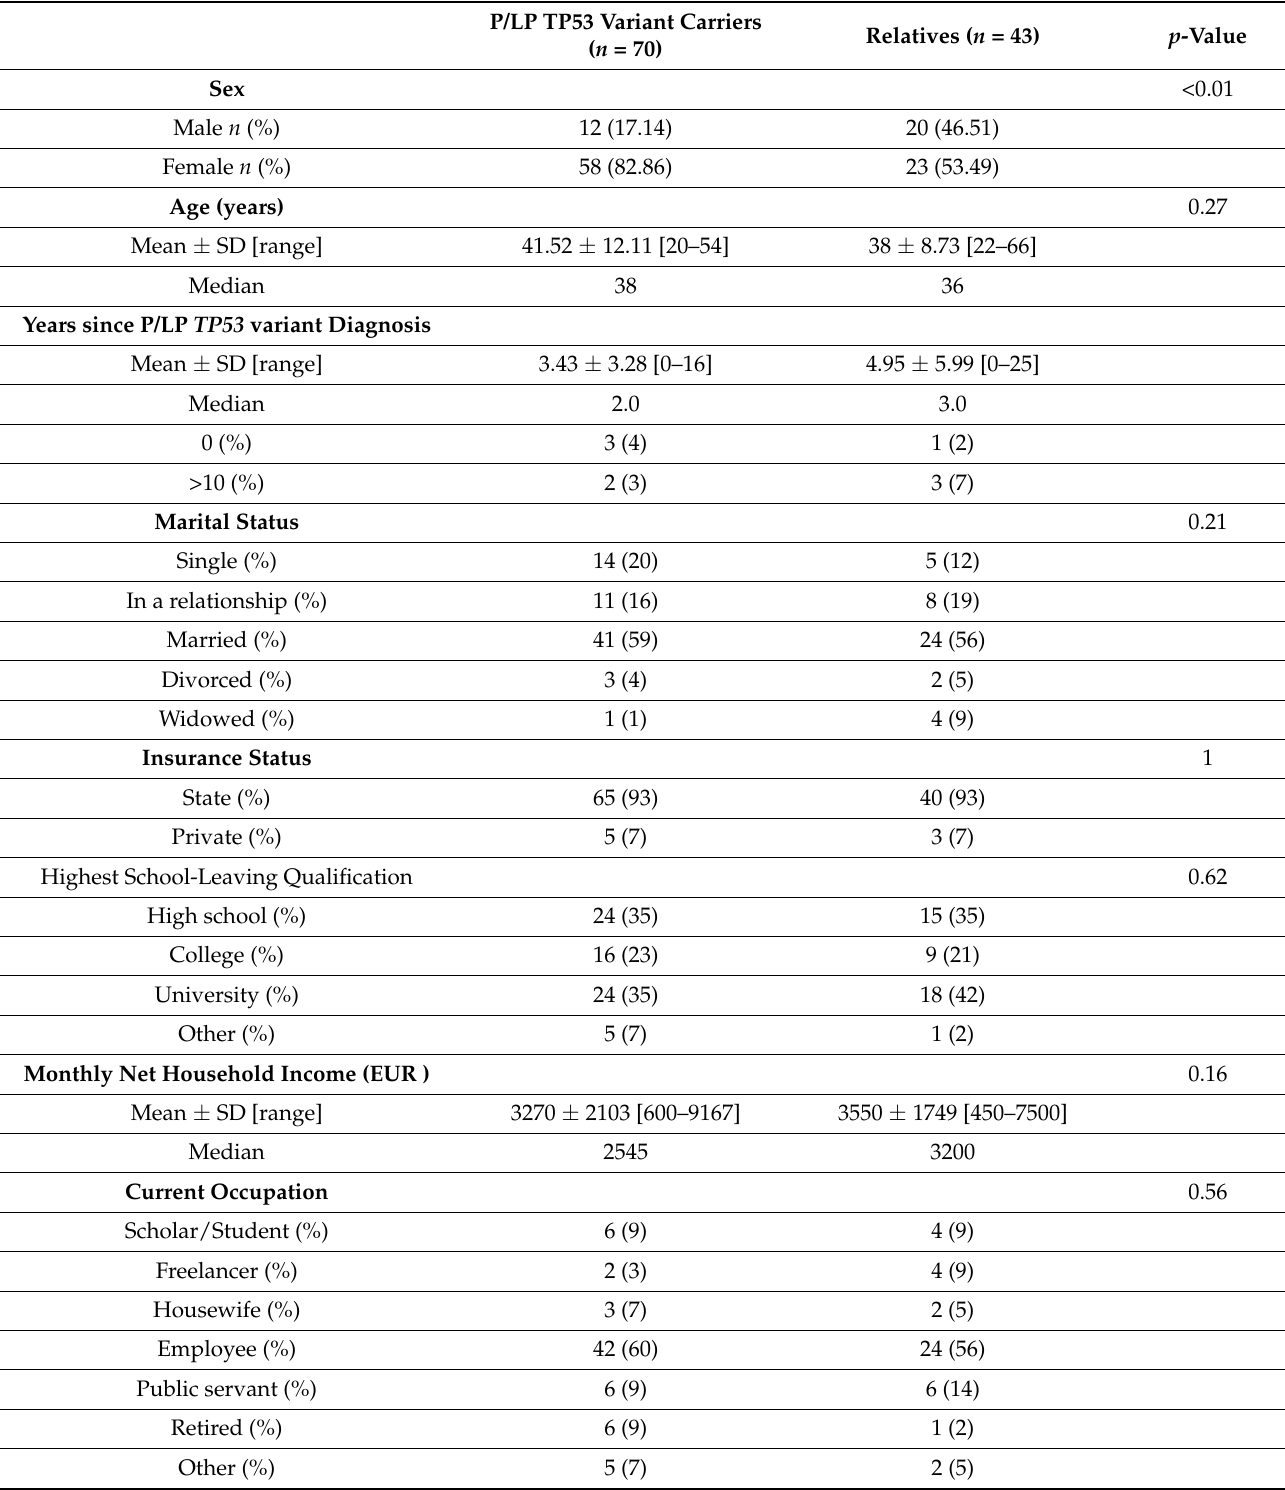
Table 1. Characteristics of all study participants with a pathogenic/likely pathogenic (P/LP) TP53 germline variant as well as their relatives as captured with the